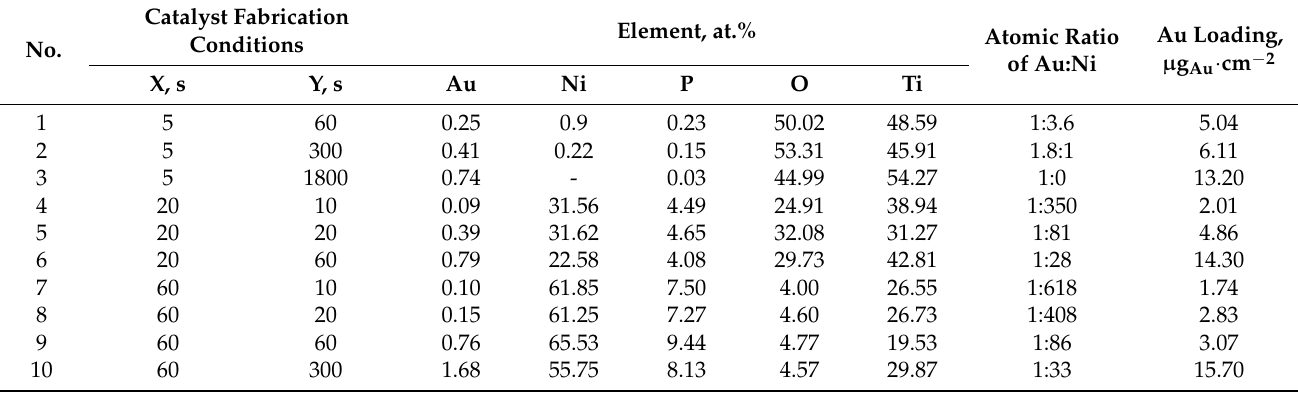
Figure 3. The surface morphology of: AuNi-TiO 2 ntb fabricated by the dipping of TiO 2 ntb in the Ni plating solution operated at 85 °C for 60 s, followed by their dipping in the Au plating solution at 25 °C for ( a ) 10, ( b ) 20, ( c ) 60, and ( d ) 300 s. The insets present the histograms of Au nanoparticle distribution. Table 2. The surface composition of the AuNi-TiO 2 ntb catalysts determined by EDX analysis. The catalysts were prepared by dipping TiO 2 ntb in the Ni plating solution at 85 ◦ C for X s, followed by immersion in the Au plating solution at 25 ◦ C for Y